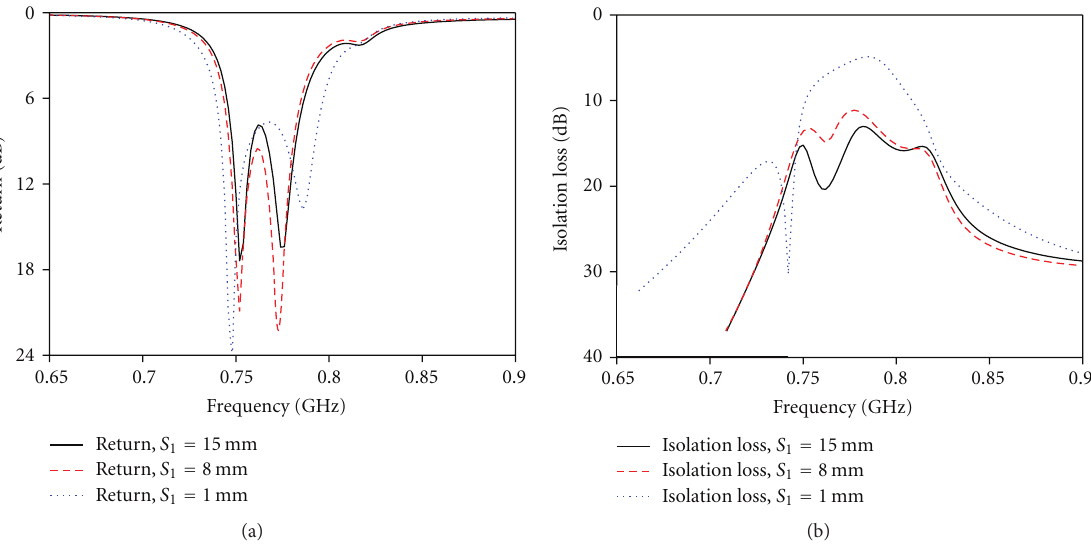
Figure 9: Return loss and isolation of the antenna with respect to a variation in distance between different radiating elements ( 𝑆 1 ): (a) return loss and (b) isolation.